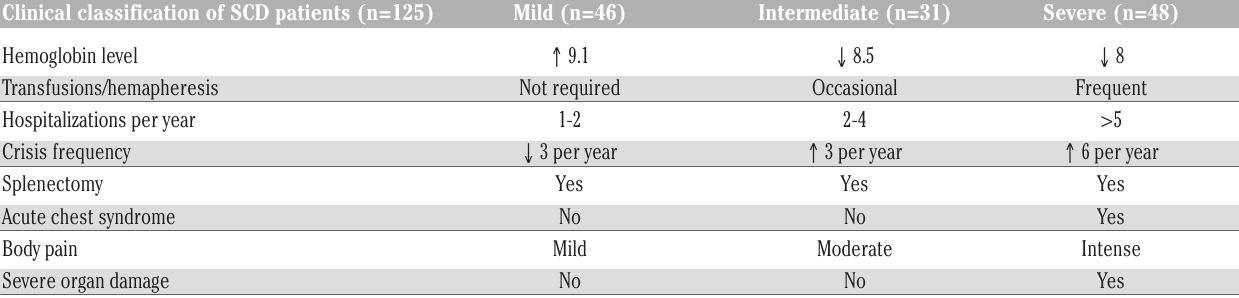
Table 2. Classification criteria for the 125 homozygous HbS/S patients to assess sickle cell disease severity into mild, intermediate and severe. Clinical classification of SCD patients (n=125) Mild (n=46) Intermediate (n=31) Severe (n=48) Hemoglobin level ↑ 9.1 ↓ 8.5 ↓ 8 Not required Occasional Frequent 1-2 2-4 >5 ↑ 6 per year Yes Yes Yes No Yes Mild Moderate Intense Severe organ damage No No